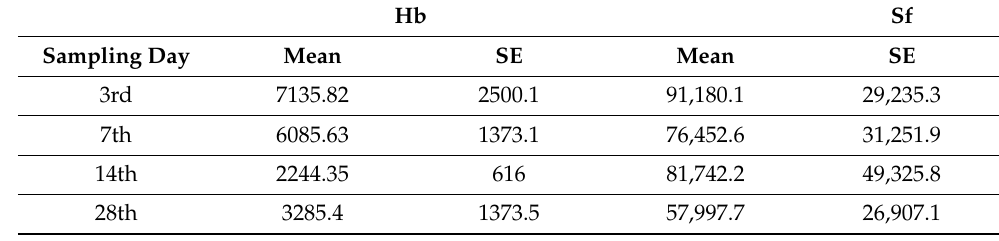
Table 1. Abundance of Steinernema feltiae (Sf) and Heterorhabditis bacteriophora (Hb) for 28 days following augmentation in a citrus orchard.